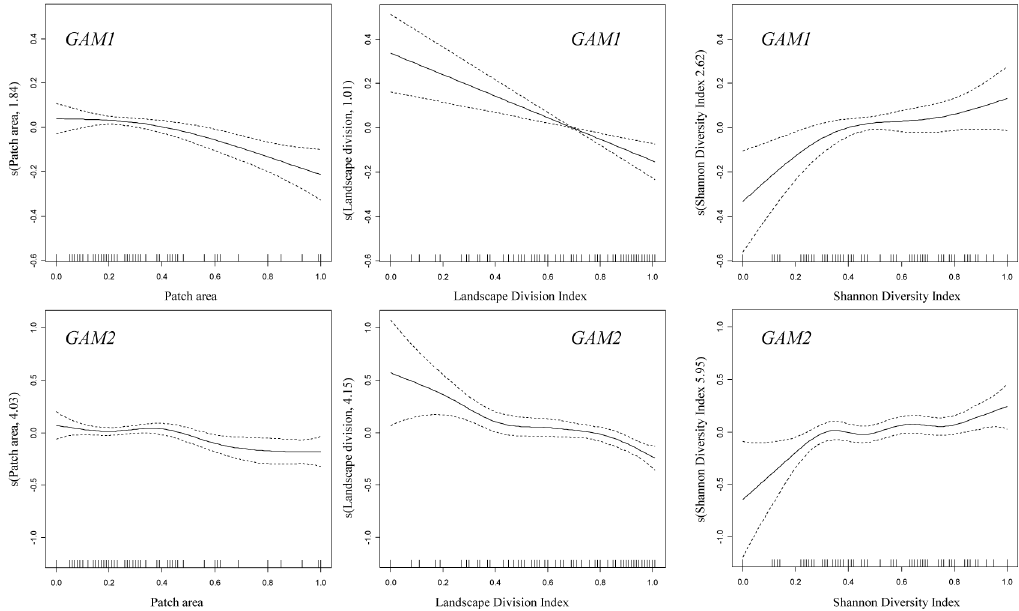
Figure 3. Estimated terms describing the dependence of avian species richness on LANDS variables (landscape variables). Estimates (solid) and 95% confidence intervals (dashed). Splines penalised to a maximum of four degrees of freedom (GAM1) are less com- plex.